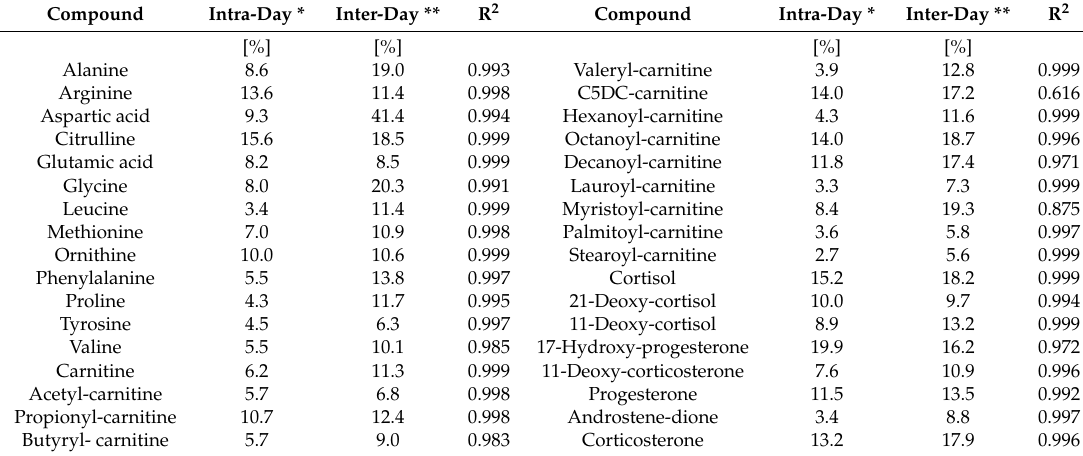
Table 1. Intra-day and inter-day precision and R 2 of